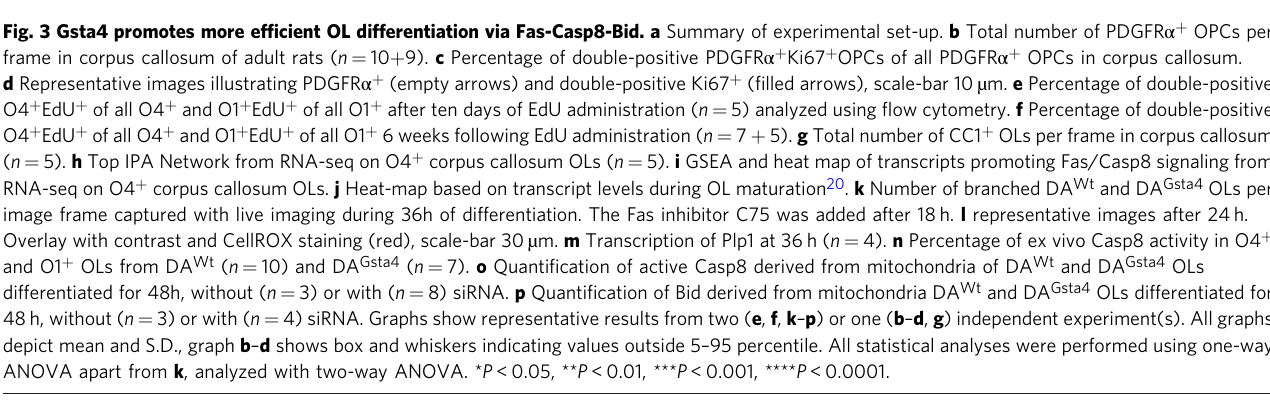
Fig. 3 Gsta4 promotes more ef fi cient OL differentiation via Fas-Casp8-Bid. a Summary of experimental set-up. b Total number of PDGFR α + OPCs per frame in corpus callosum of adult rats ( n = 10 + 9). c Percentage of double-positive PDGFR α + Ki67 + OPCs of all PDGFR α + OPCs in corpus callosum. d Representative images illustrating PDGFR α + (empty arrows) and double-positive Ki67 + ( fi lled arrows), scale-bar 10 µ m. e Percentage of double-positive O4 + EdU + of all O4 + and O1 + EdU + of all O1 + after ten days of EdU administration ( n = 5) analyzed using fl ow cytometry. f Percentage of double-positive O4 + EdU + of all O4 + and O1 + EdU + of all O1 + 6 weeks following EdU administration ( n = 7 + 5). g Total number of CC1 + OLs per frame in corpus